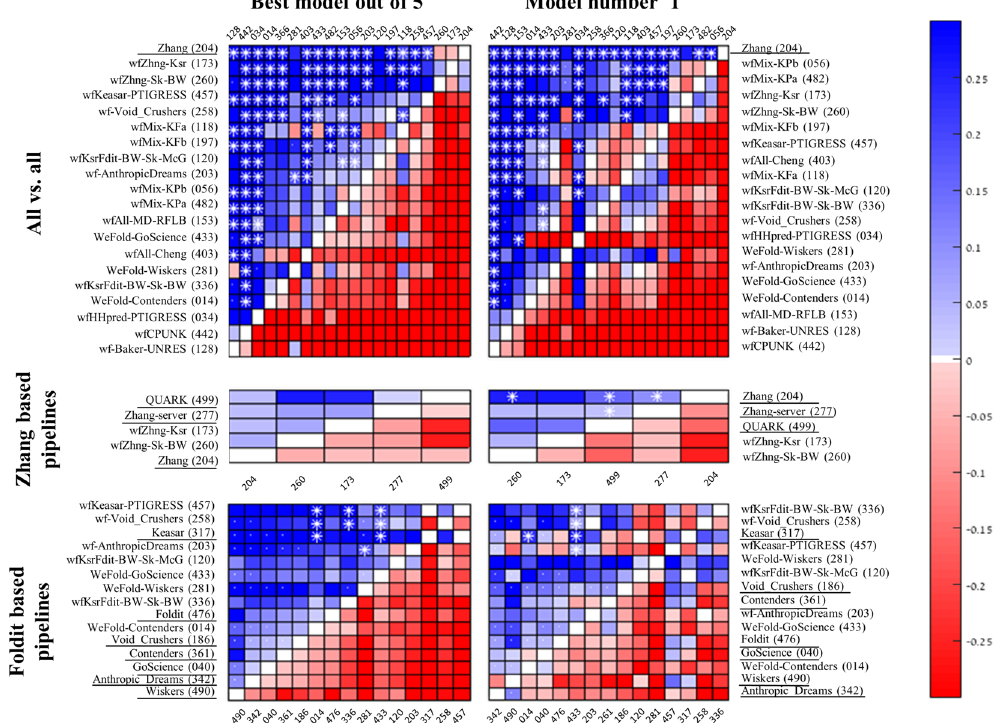
Figure 5. Pairwise comparison of WeFold and related (underlined) CASP11 groups. Each cell represents a comparison between the row and column groups, based on the subset of targets they both predicted. Cell colors depict the difference in average z-scores (GDT_TS). Blue indicate better performance of the row group. Asterisks indicate statistical significance (p < 0.05; Wilcoxon two-sided pair test). Dots indicate that the two groups shared no more than ten targets. Rows are ordered by decreasing number of significant cells, and then by blue cells. Source: